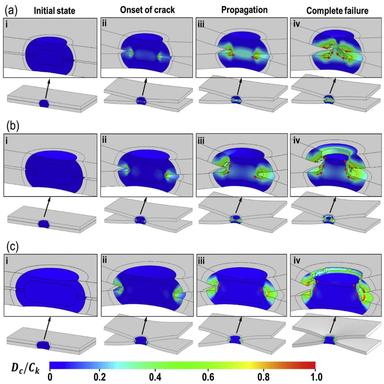
Evolution of damage accumulation index Dc/Ck and the crack propagation process during the cross-tension tests. (a) Case-1; (b) Case-2; and (c) Case-3. Note that the subfigures i-iv correspond to the initial, onset of crack, crack propagation, and complete failure states in each case.